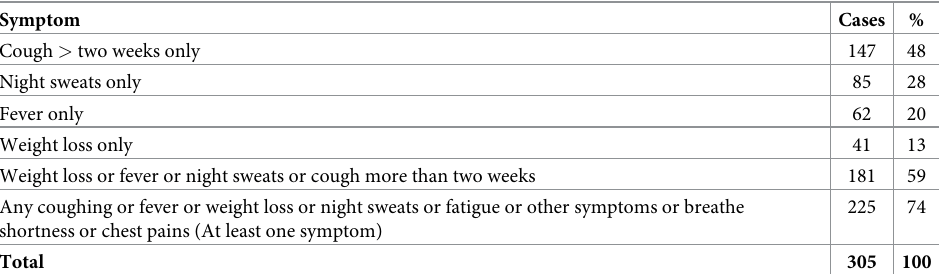
Table 5. Symptoms profile of the prevalent TB cases.